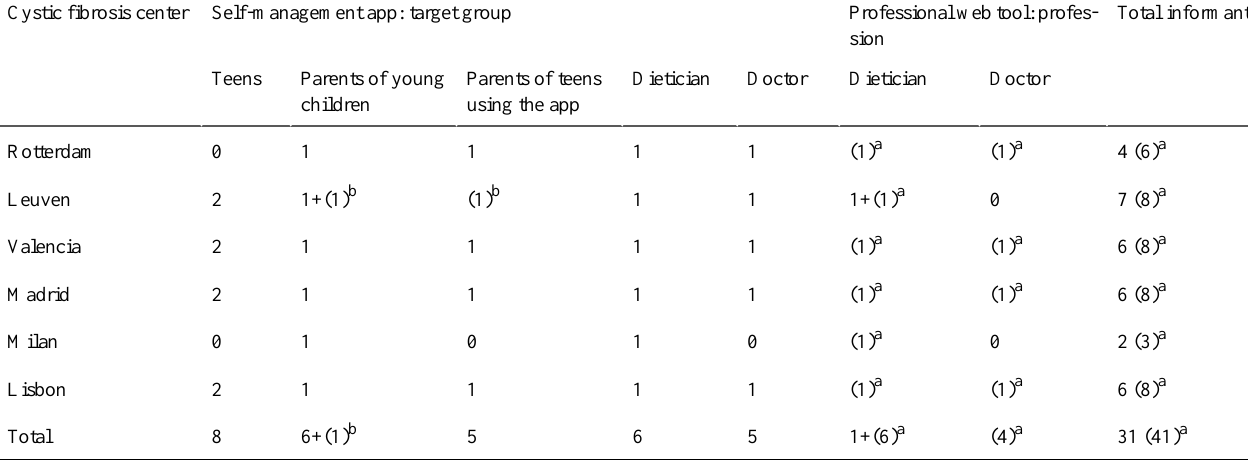
Table 1. Overview of the target groups and informants across cystic fibrosis centers and